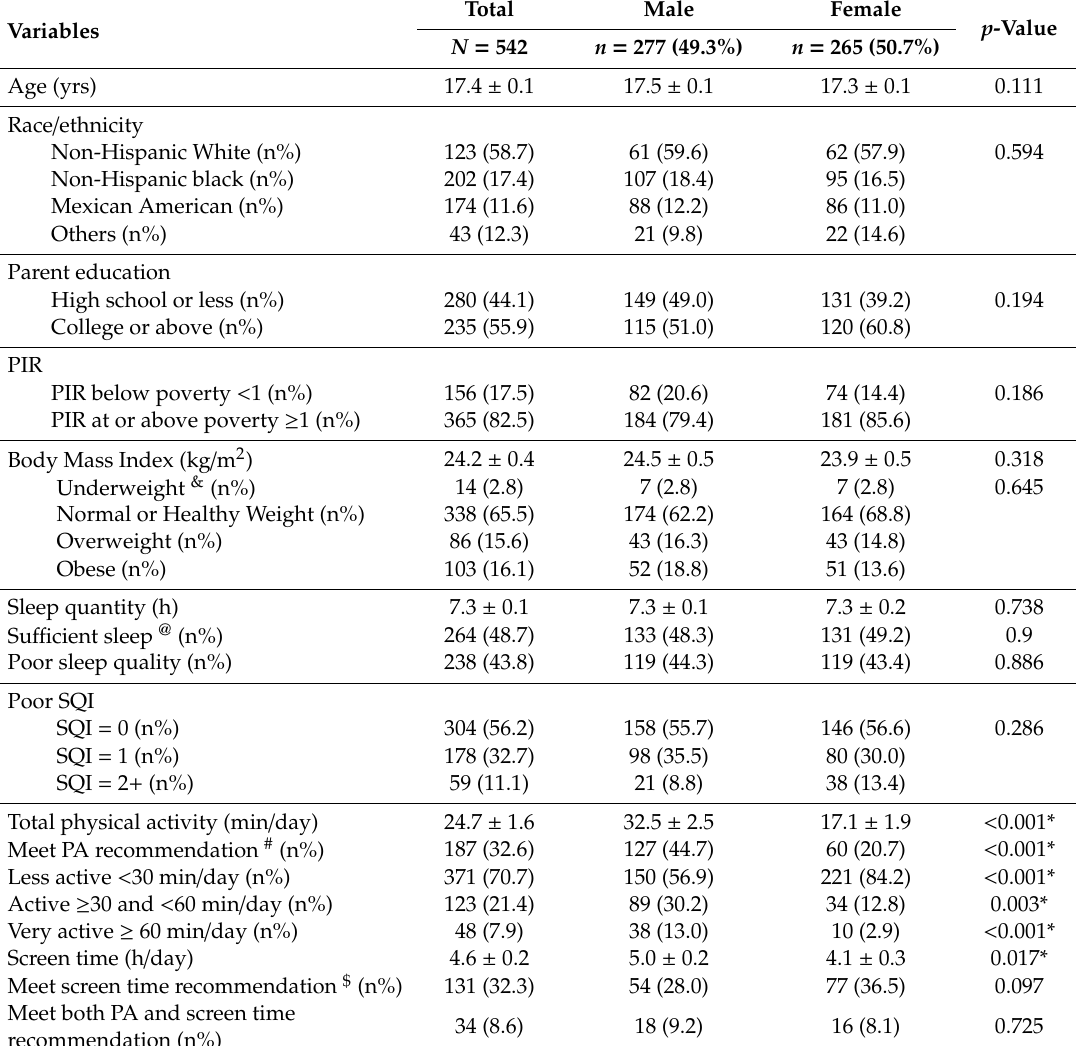
Table 1. Respondents’ characteristics by sex, 2005–2006 National Health and Nutrition Examination Survey (NHANES) ( N =